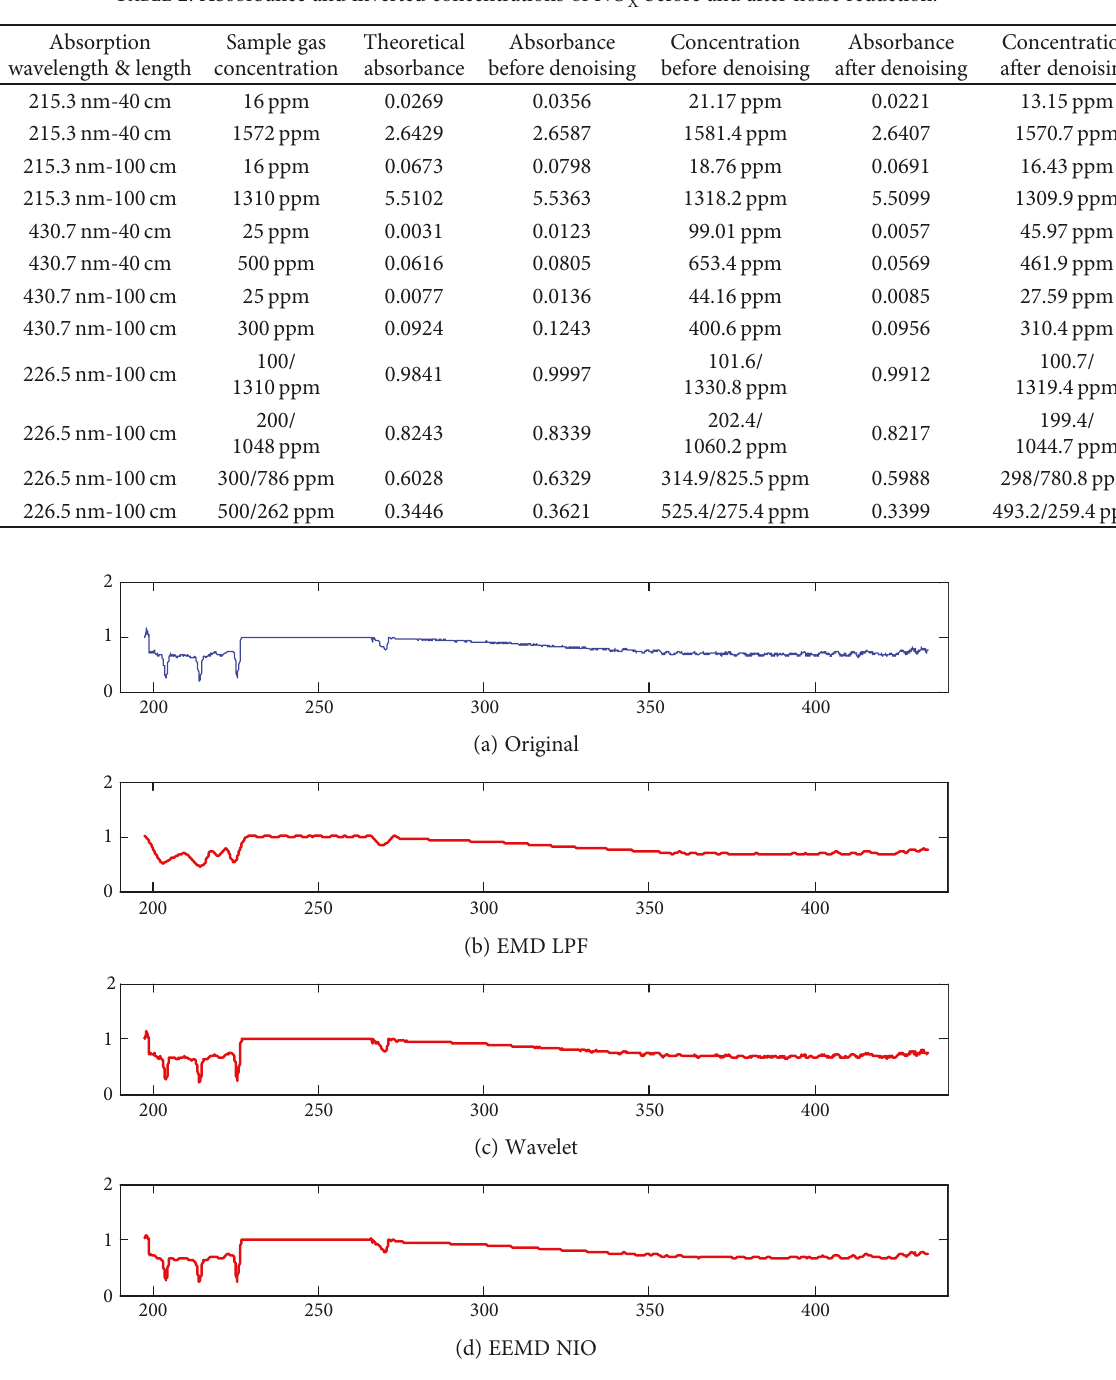
Table 2: Absorbance and inverted concentrations of NO